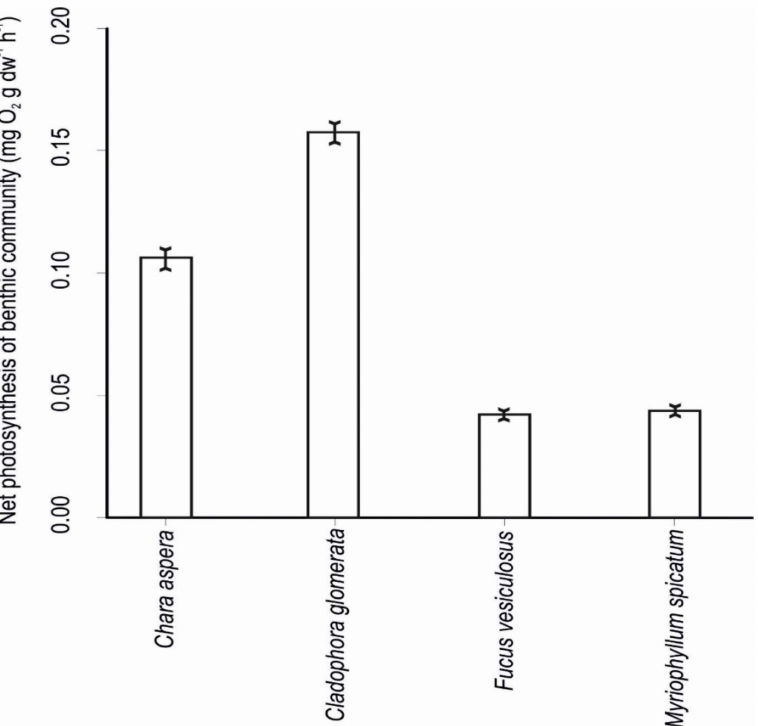
Figure 6. Community net production rates of different plant classes in the study area (means ± standard error).